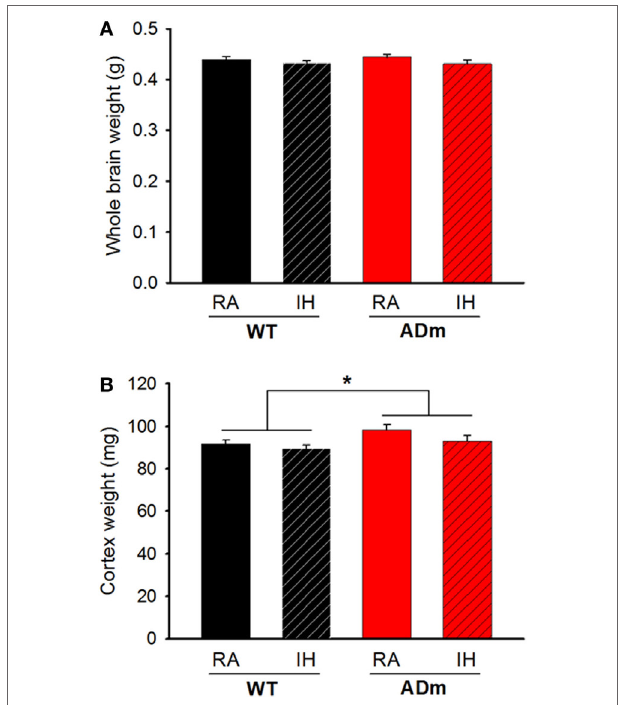
FigUre 2 | Cerebral and cortical weights. (a) Whole brain weights from the four experimental groups: WT mice subjected to RA (black bar) and IH (dashed black bar) and ADm mice subjected to RA (red bar) and IH (dashed red bar). Two-way ANOVA revealed no differences between experimental groups (IH vs. normoxia; DF = 1, F = 2.654, p = 0.111 and WT vs. ADm; DF = 1, F = 0.0992, p = 0.754). (B) Cortical weights from all the four experimental groups: WT mice subjected to RA (black bar) and IH (dashed black bar) and ADm mice subjected to RA (red bar) and IH (dashed red bar). Cortical weight was significantly higher in ADm mice compared to littermate controls (WT) (DF = 1, F = 6.042, p = 0.019). Two-way ANOVA analysis, * p < 0.05. Data are presented as mean ± SE. WT, wild type; RA, room air; IH, intermittent hypoxia; ADm, Alzheimer’s disease transgenic mouse.